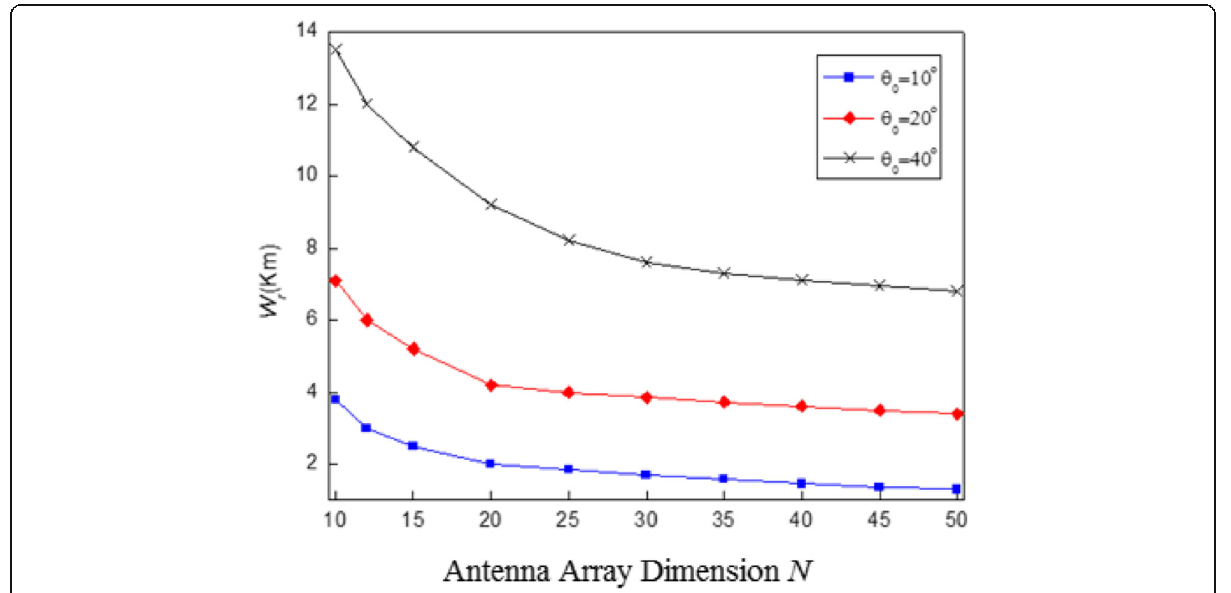
Fig. 5 Relationship between antenna dimensions and ring cell width under different antenna elevation angles θ 0